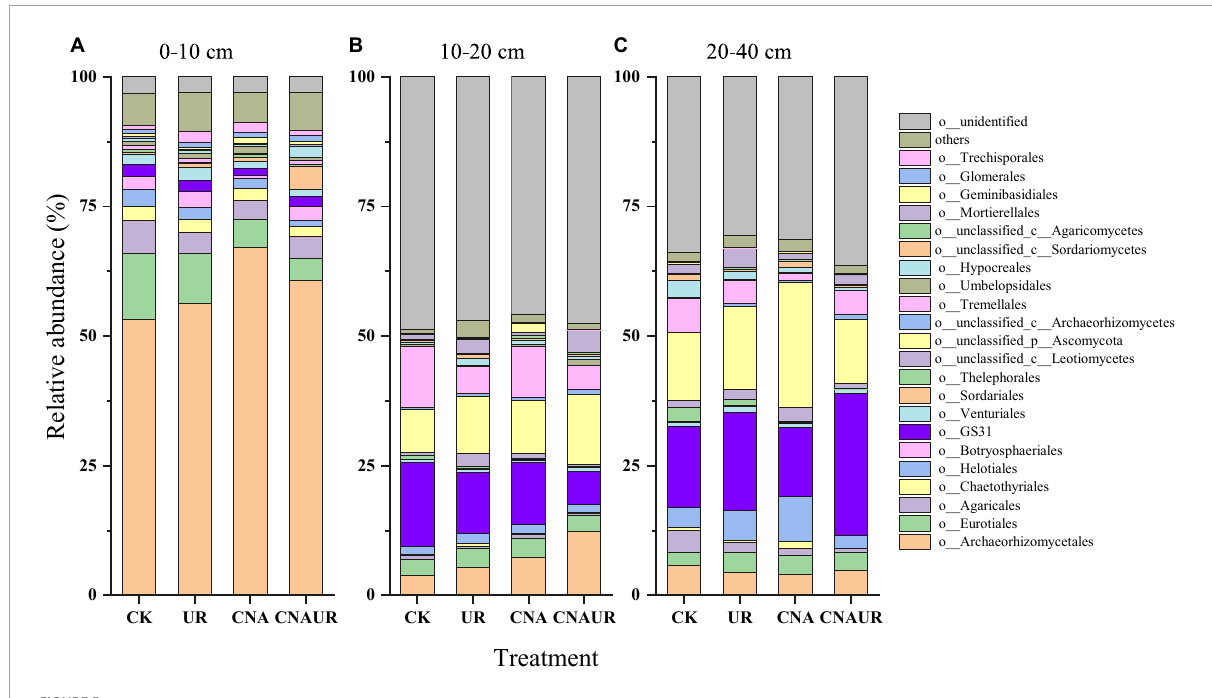
FIGURE5 Relative abundance of soil fungal community at the order level under treatments (treatments are described in Table 1 ) in three soil layers, 0–10 cm (A) , 10–20 cm (B) , and 20–40 cm (C) . Those orders that represent > 0.1% of the fungal community abundance are named, while those that represent < 0.1% of the fungal community abundance are referred to as “others.”